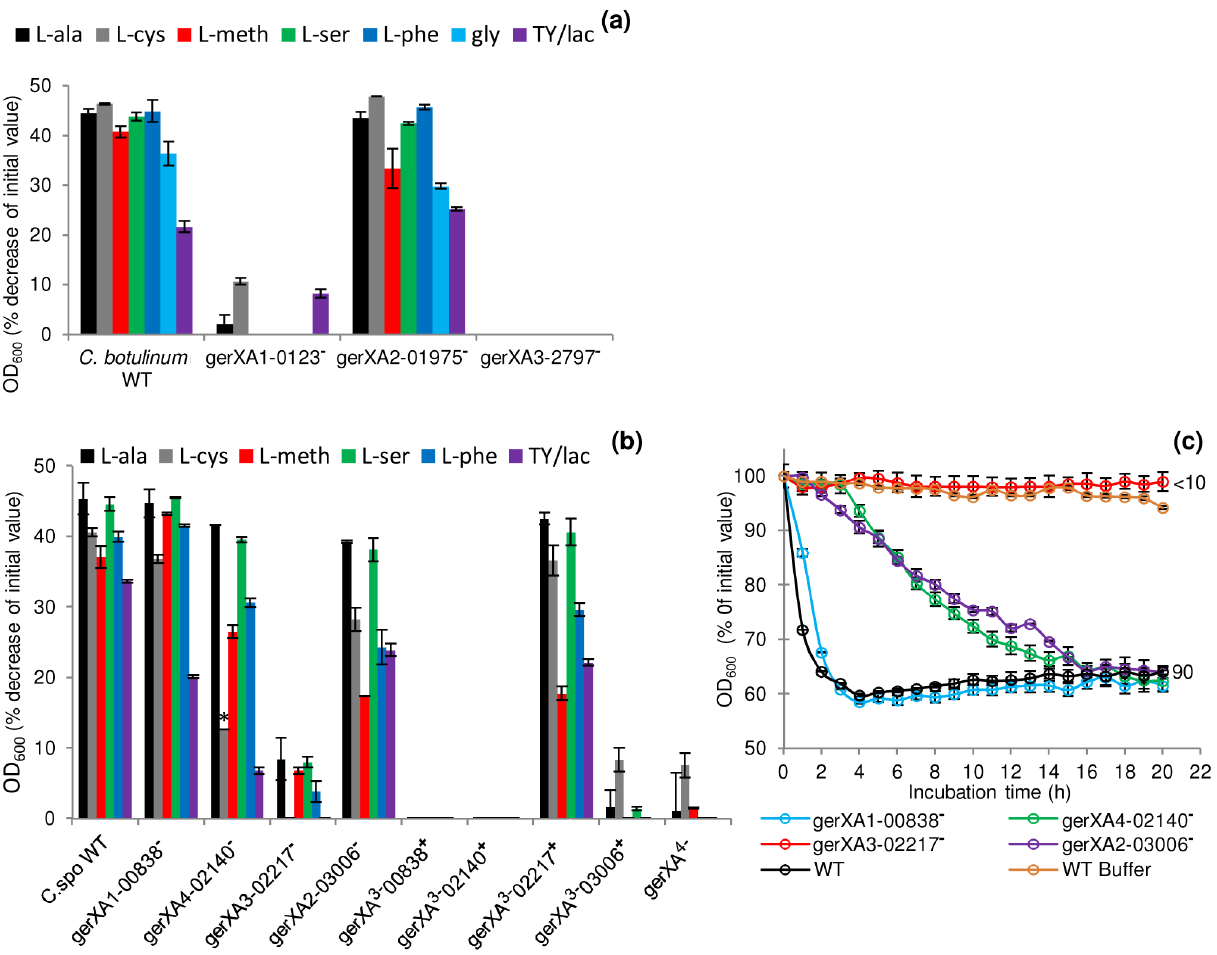
Figure 4. Mutation of specific receptors precludes amino acid stimulated germination. Spores were incubated in 20 mM Tris buffer, pH 7.4, amino acid (100 mM) + L-lactate (50 mM) and NaHCO 3 (50 mM) at 30 u C for 20 hours with L-alanine, L-cysteine, L-methionine, L-serine, L- phenylalanine, glycine ( C. botulinum only) or in TY + L-lactate (50 mM). (a) C. botulinum single insertional knockout mutants and wild type spore germination. (b) C. sporogenes single insertional knockout mutants, triple insertional knockout mutants, quadruple insertional knockout GR mutant and wild type spore germination. * L-cysteine is a relatively insoluble amino acid and precipitates out of solution after 2 hours. Due to the 4 hour delay in germination of the mutant gerXA4 -02140 2 cysteine precipitation caused OD 600 readings to be unrepresentative and therefore germination was confirmed by microscopy. (c) Alanine induced germination rates of single insertional knockout GR mutants for C. sporogenes were determined using spores generated from the wild type ( C. sporogenes ATCC15579) and mutants gerXA1 -00838 2 , gerXA4 -02140 2 , gerXA3 -02217 2 , gerXA2 -03006 2 . WT spores incubated in buffer only (see above), were included as a negative control (WT Buffer). Data labels (right) refer to percentage germination observed by phase contrast microscopy at the end of the experiment. Error bars in (a–c) represent the standard deviation of 3 independent experiments. Spore germination was confirmed by phase contrast microscopy.